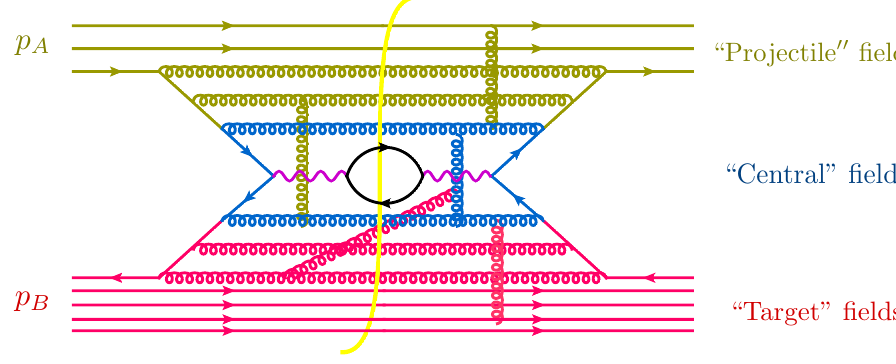
Figure 1 . Rapidity factorization for DY particle